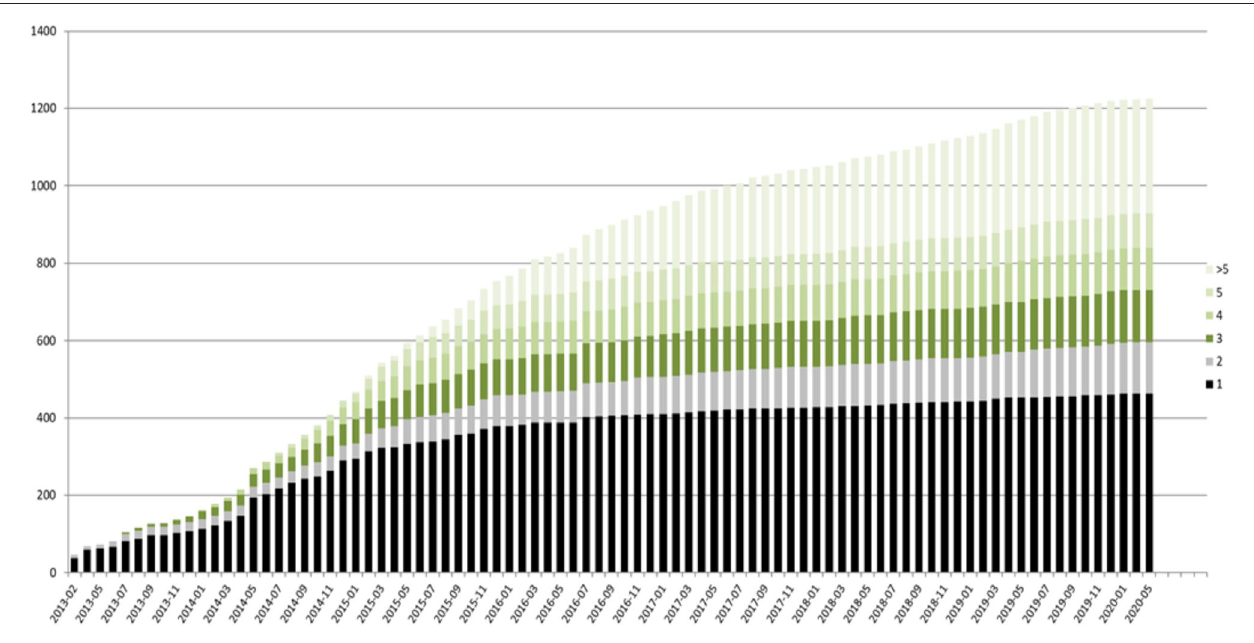
FIGURE 4 | TIRCON registry—baseline (black) and follow-up visits (different colors used, depending on the total number of follow-up visits) over